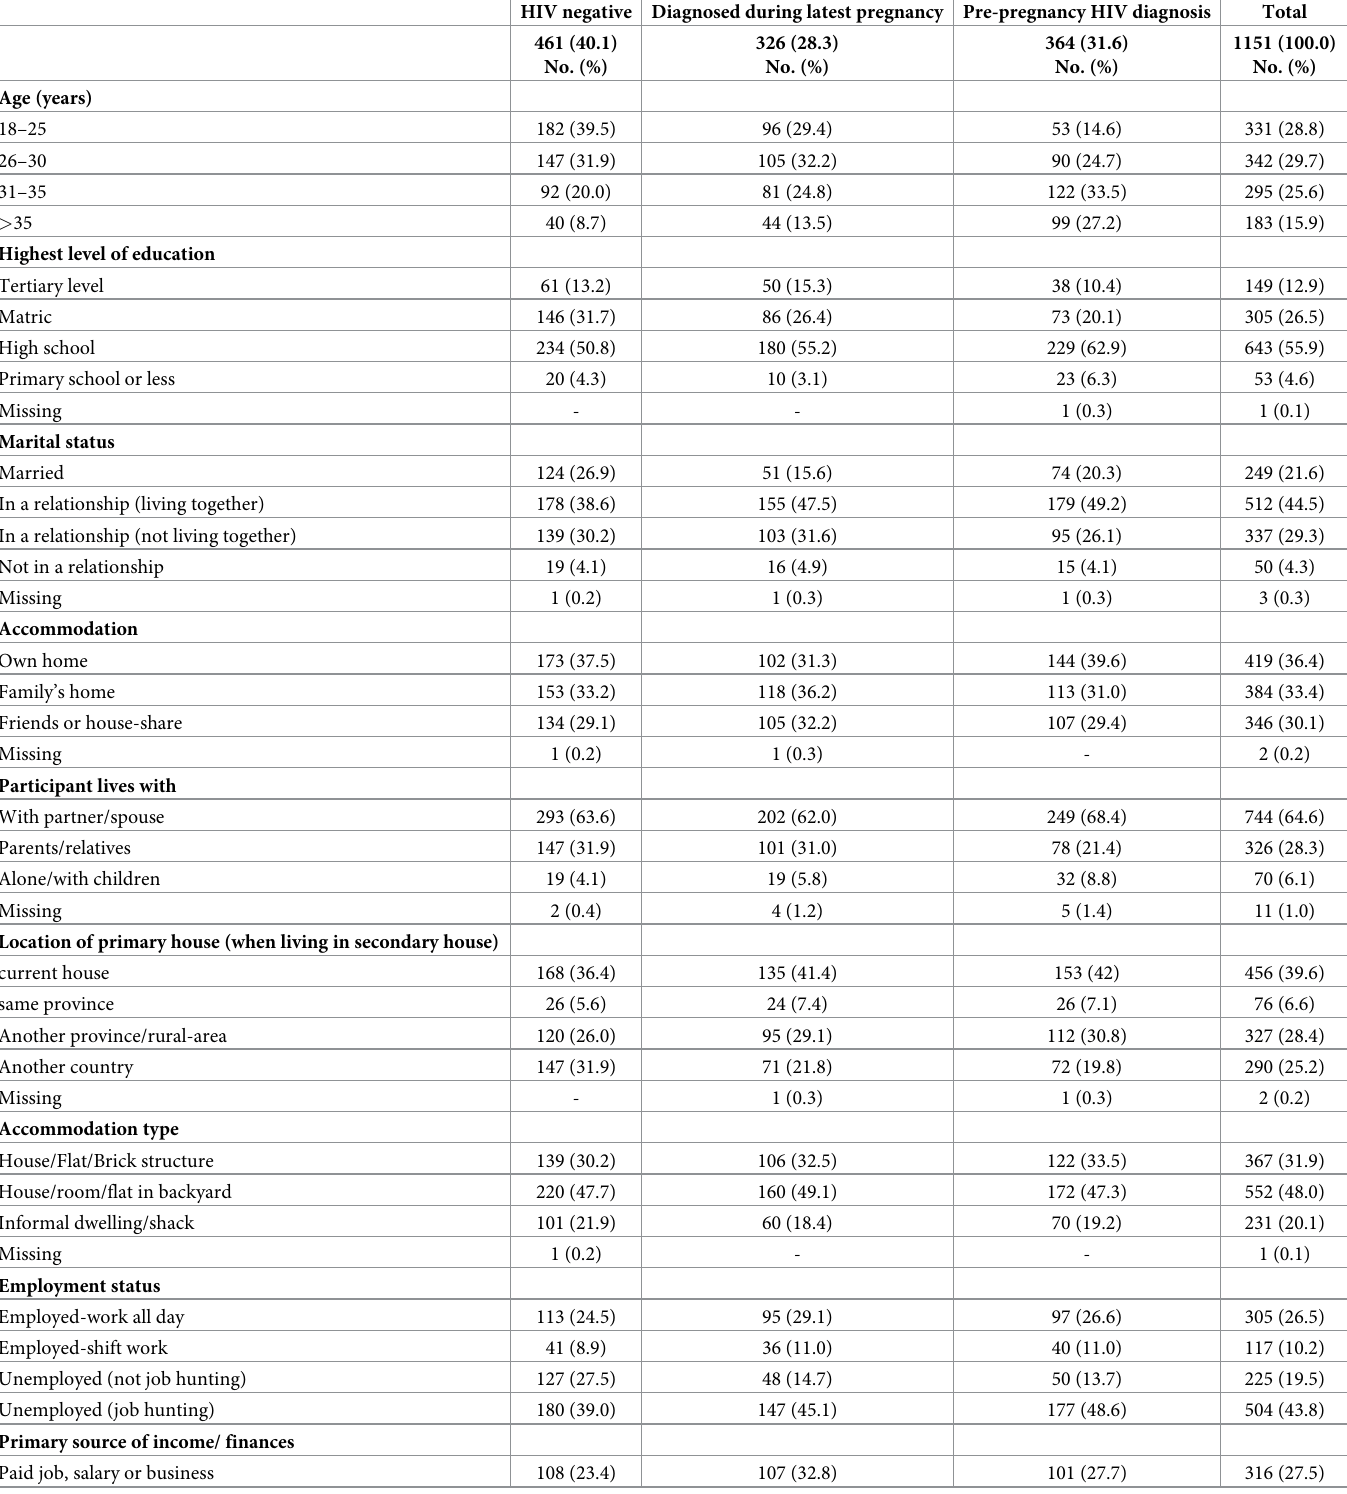
Table 1. Participant characteristics (all